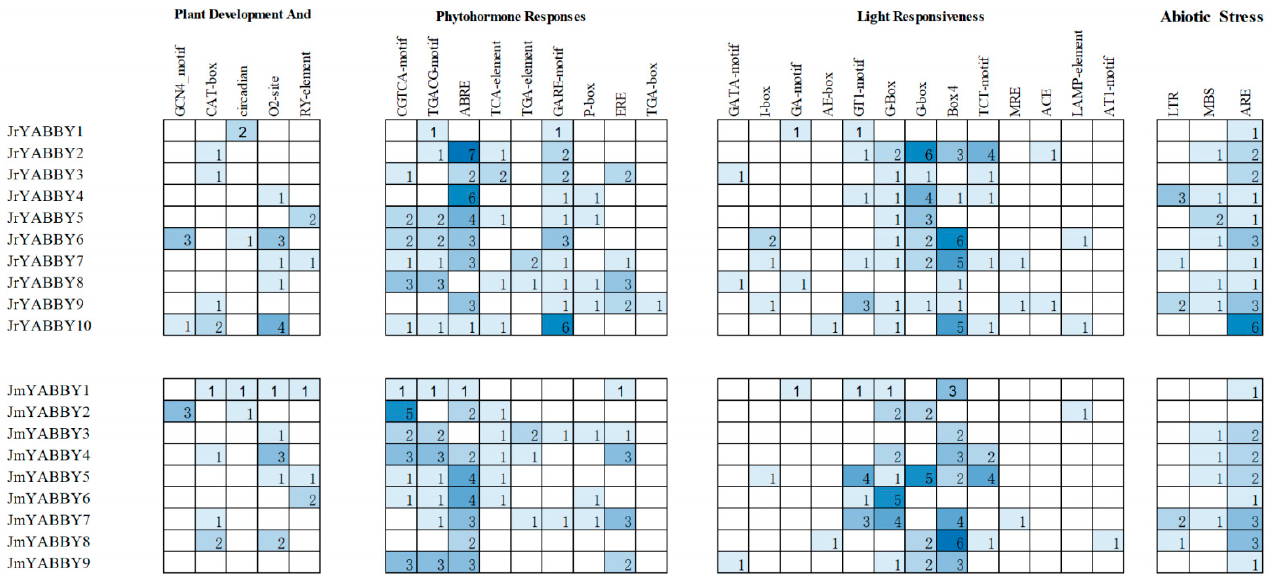
Figure 5. Cis ‐ acting elements in promoter regions of YABBY genes in two Juglans species. Based on functional annotations, the cis ‐ acting elements were categorized into four major classes: plant development and growth, phytohormone responses, abiotic stress responses, and light responsive cis ‐ acting elements. Numbers in the colored boxes represent the number of cis ‐ acting elements.